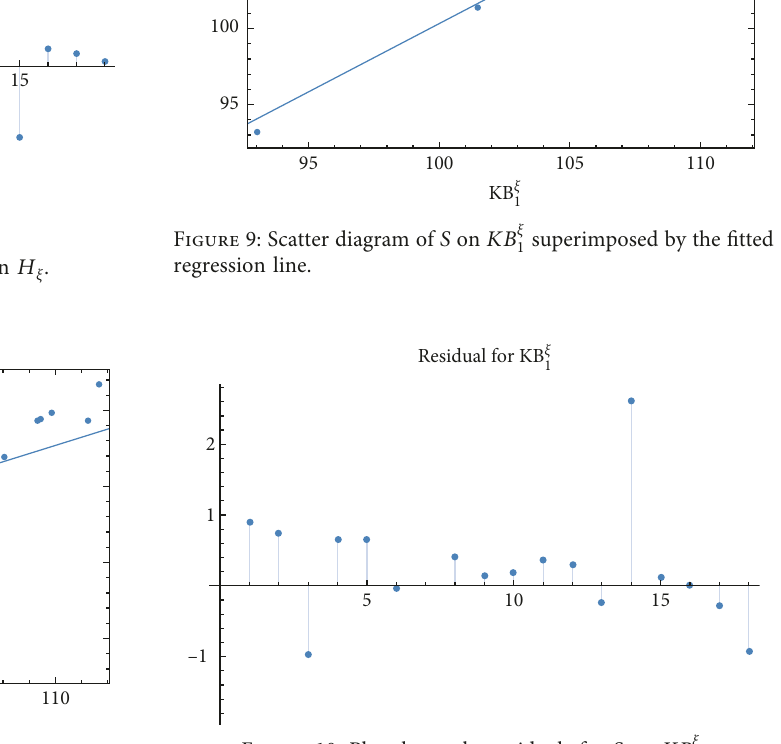
Figure 7: Scatter diagram of S on GA regression line.